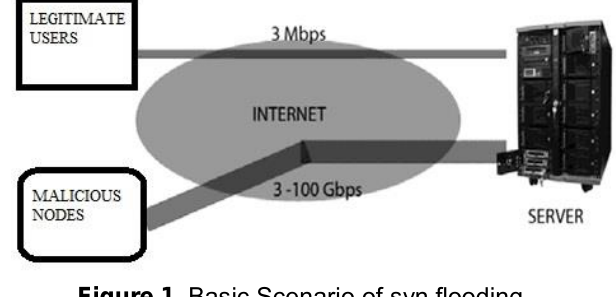
Figure 1. Basic Scenario of syn flooding